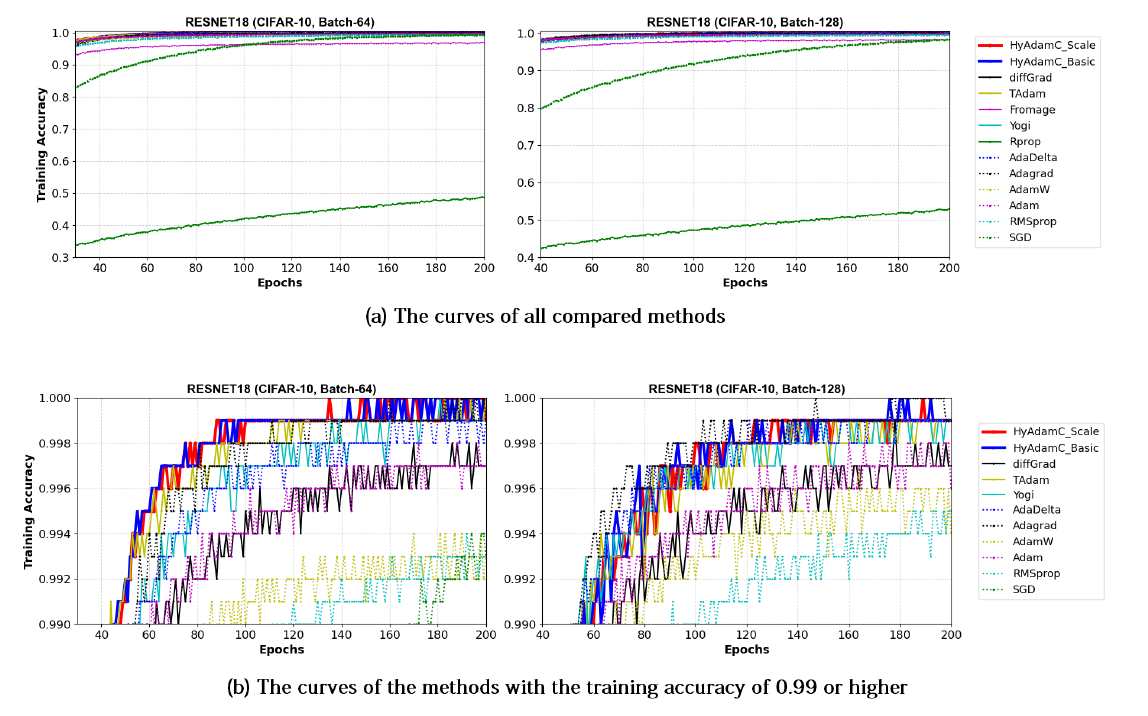
Figure 17. The training accuracy curves of the ResNet-18 trained by HyAdamC and other optimization methods in the CIFAR-10 image classification tasks. In this figure, ( a ) shows the training accuracy curves of all compared methods. On the other hand, ( b ) illustrates the plots in which a range of the y-axis of the plots described in ( a ) is zoomed into between 0.99 and 1.